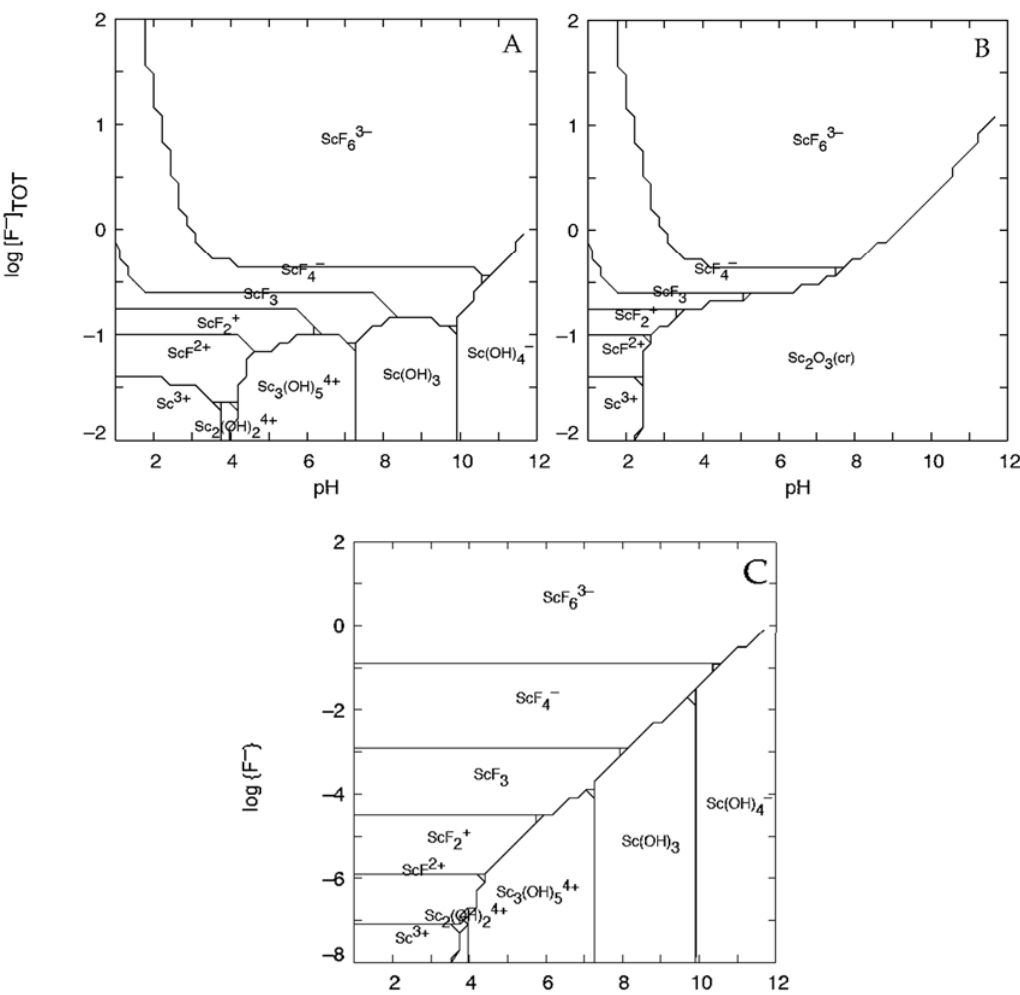
Figure 1. Predominance area diagram of Sc species in fluoride medium at 67 mmol/L (3000 mg/L) Sc at 25 °C. ( A ) Soluble complexes only with respect to logarithm of total fluoride ion concentration and pH; ( B ) Soluble complexes and solids formation with respect to logarithm of total fluoride concentration and pH; ( C ) Soluble complexes only with respect to logarithm of fluoride activity and pH.